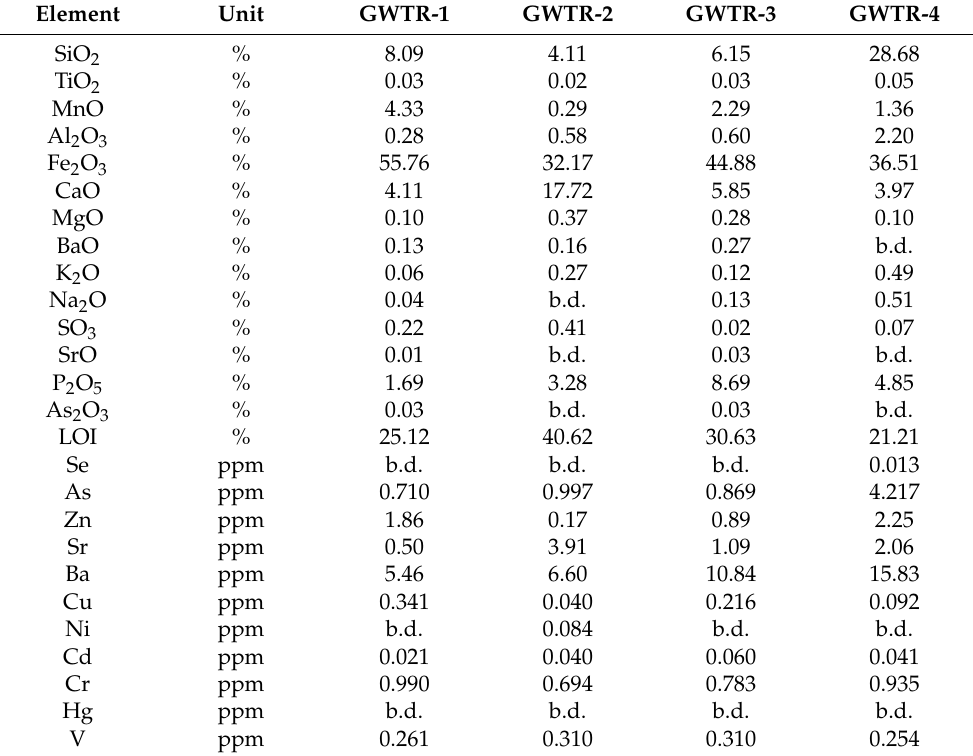
Table 2. Chemical composition of